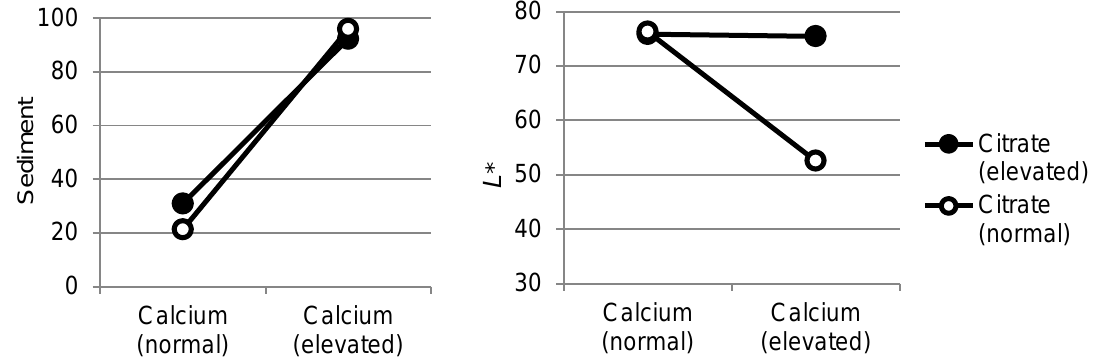
Figure 5. The interaction effects of calcium and citrate, for average values of all samples with normal and elevated levels, on sediment formation and L * (lightness) for ultra-high temperature treated milk stored for 0–52 weeks at 4, 20, 30, and 37 °C.